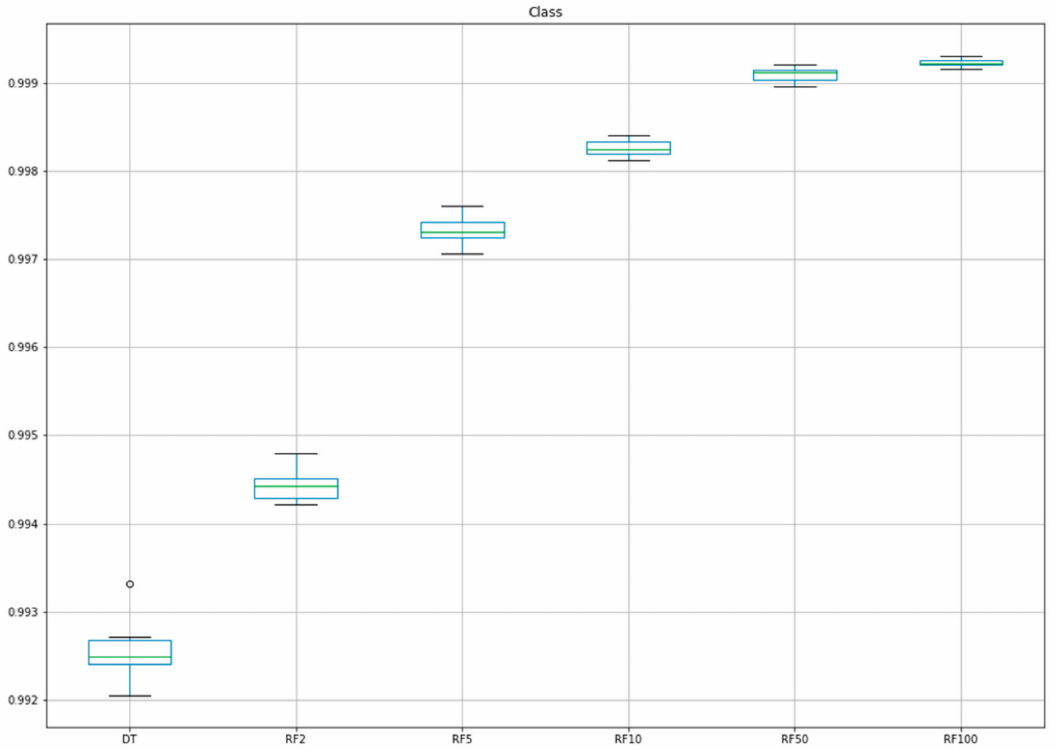
Figure 3. Box plot for the AUROC values of the NET-NET AutoML classification